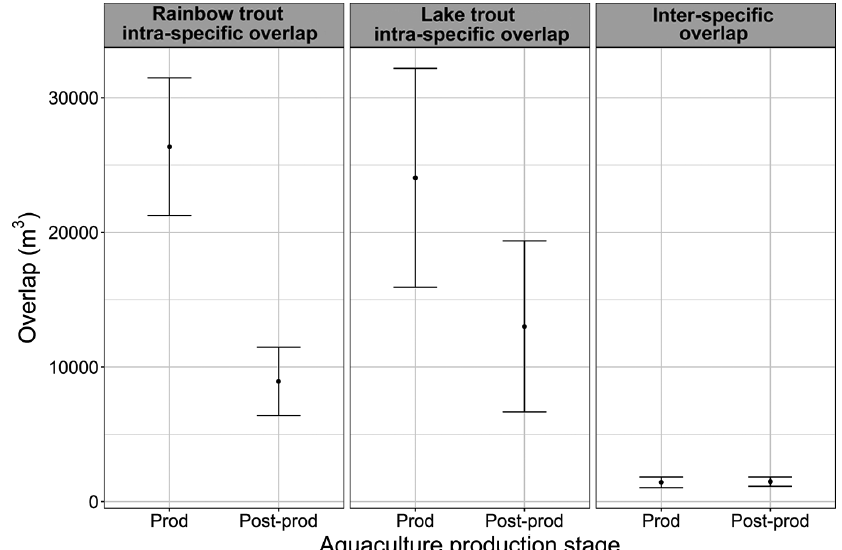
Fig. 5. Inter- and intra-specific 50% 3D kernel utilization distribution (KUD) overlap for rainbow trout Oncorhynchus mykiss and lake trout Salvelinus namaycush in periods of aquaculture production (Prod) and post-production (Post-prod). Overlap between groups is shown in cubic meters (m 3 )